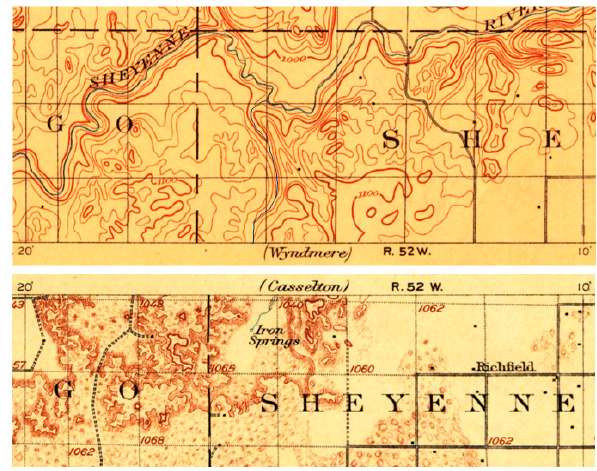
Figure 2. Historical 1:125,000-scale topographic maps (north - 1897 Casselton quadrangle; south - 1907 Wyndmere quadrangle) showing the location of Iron Springs (near the center of section 19, T147N, R52W), Iron Springs Creek, and the Sheyenne River. The grid shows U.S. Public Land Survey system sections (approximately one square mile) within Township 135 North, Range 52 West and Range 53 West.